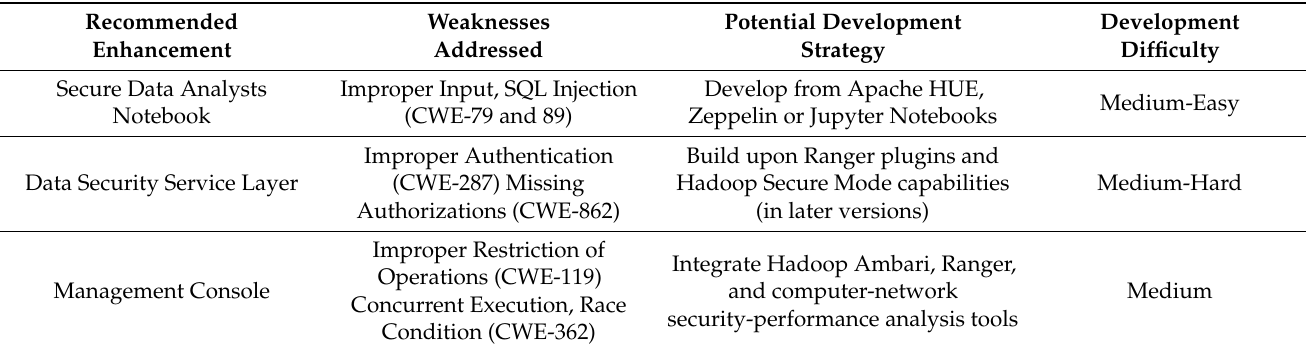
Table 5. Implementation considerations were identified in the prototype